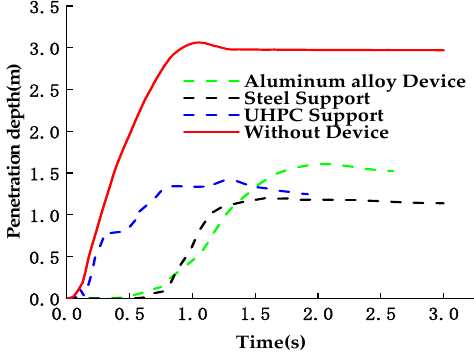
Figure 16. Bow impact depth time-history curve.